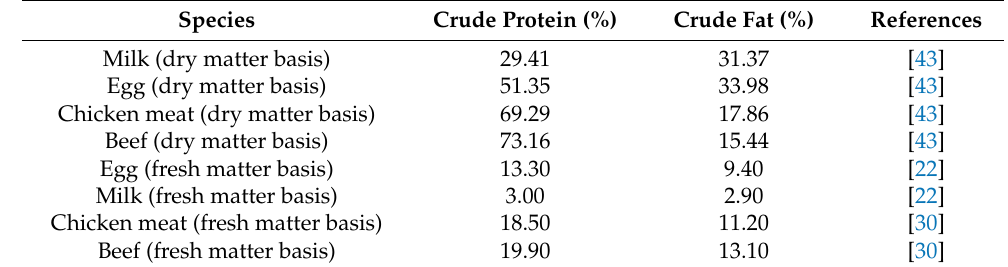
Table 3. Comparison of some items in the diet of zoo pangolins based on a dry and fresh matter